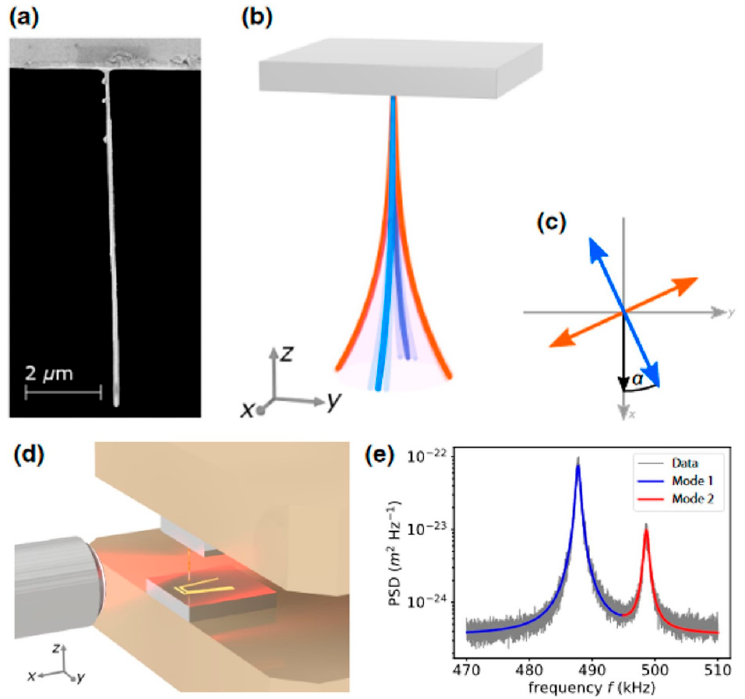
Figure 9. ( a ) SEM image of a Co-FEBID nanowire. ( b ) Sketch of the nanowire flexural modes. ( c ) Projection of the flexural modes onto the X-Y plane. ( d ) Illustration of the detection scheme for the nanowire motion. ( e ) Thermally excited response of the upper and lower modes at room temperature. Adapted from [43].